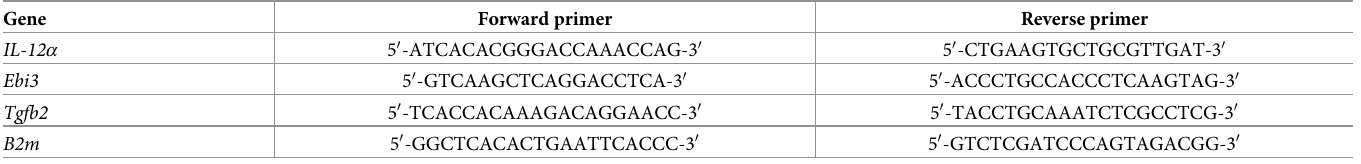
Table 1. Primers used for quantified reverse transcription PCR.